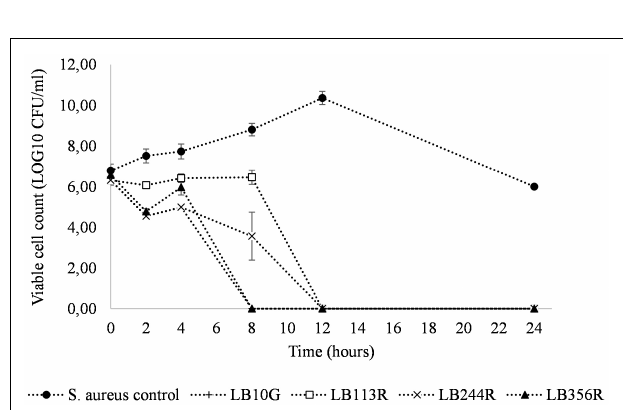
FIGURE 4 | Co-culture of Staphylococcus aureus CC-type 1 and the four hit strains Lactiplantibacillus plantarum subsp. plantarum LB113R, LB244R and LB356R and Weissella viridescens LB10G over time. The growth of S. aureus is detected on S. aureus selective MSA agar plates with a detection limit of 100 CFU/g. The values are the mean ± standard deviations of triplicates repeated in two individual experiments.